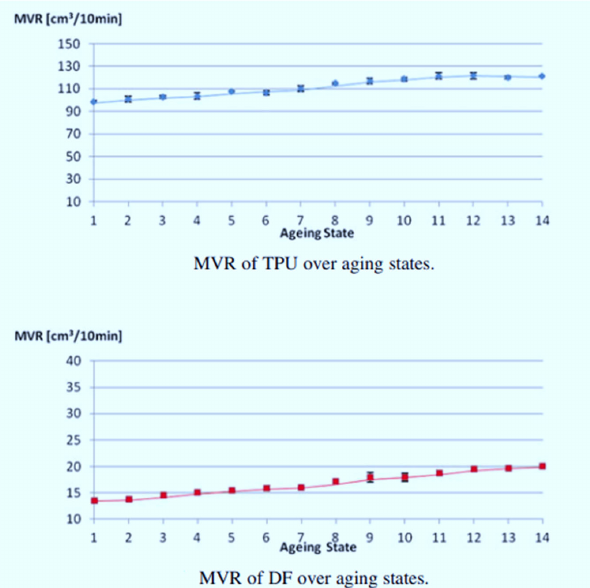
Figure 5. Changes in melt volume ‐ flow rate for TPU and DF over different aging states